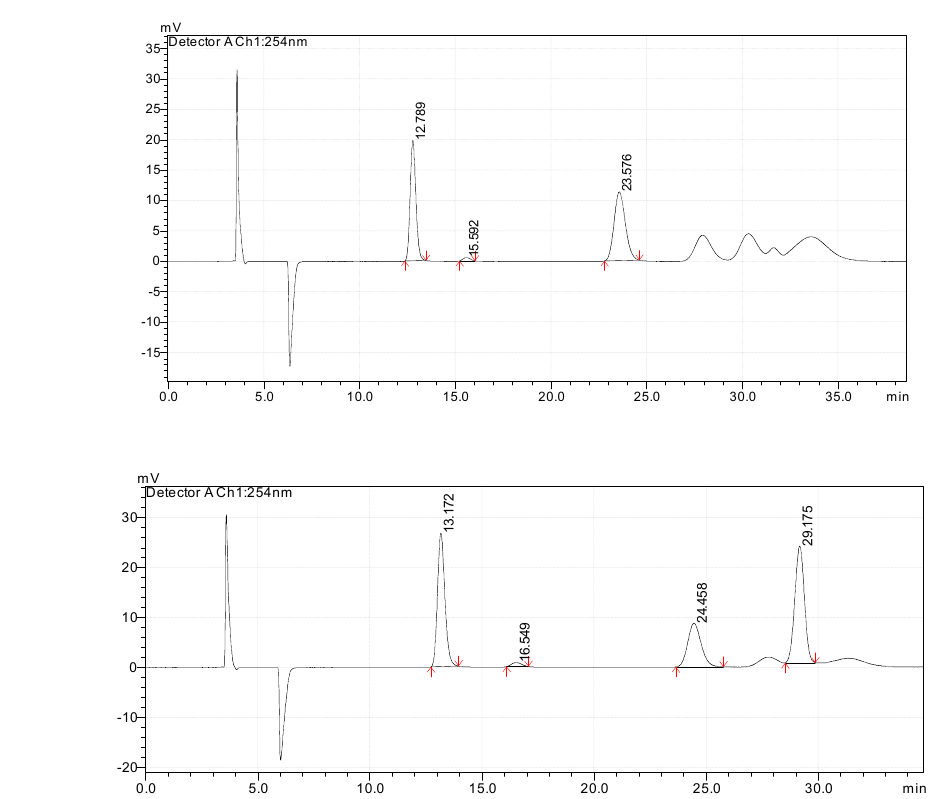
Figure 2. HPLC chromatograms of ( R , S )-flurbiprofen methyl esters. ( a ) ( R , S )-flurbiprofen methyl ester, reaction time 96 h, IB-A171, DCM; t R 12.789 ( R )-enantiomer of methyl ester, t R 15.592 ( S )-enantiomer of methyl ester; ( b ) ( R , S )-flurbiprofen methyl ester, reaction time 46 h, IB-A171, DCE; t R 13.172 ( R )-enantiomer of methyl ester, t R 16.549 ( S )-enantiomer of methyl ester; Chromatographic conditions: Lux Cellulose-3 (4.6 mm × 250 mm × 5 μ m) column; mobile phase: n -heptane/2- propanol/trifluoroacetic acid (97.6/2.4/0.2 v/v/v ), flow rate = 1 mL/min, t = 15 °C, UV = 254 nm.